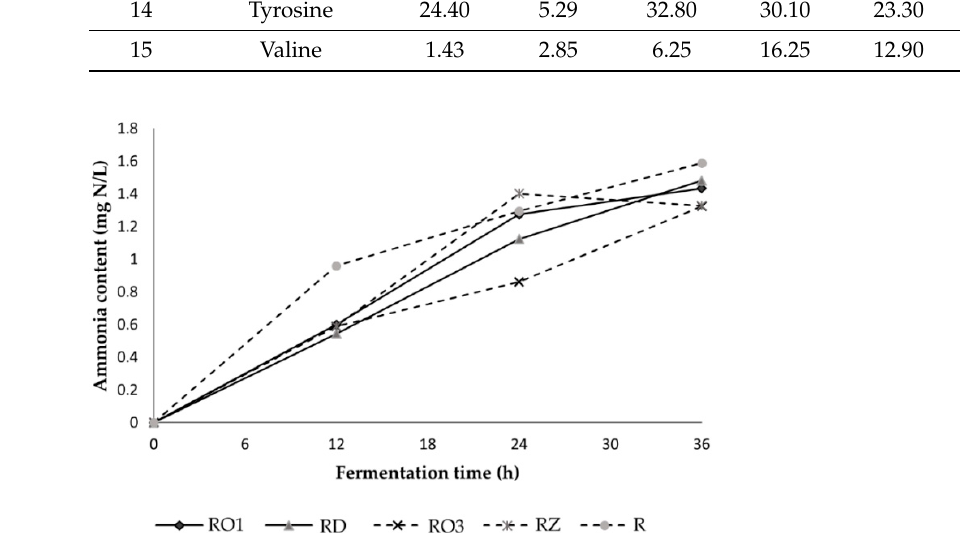
Figure 2. Changes in the Ammonia Profile during Fermentation of Soybean with Various Rhizopus Strains.